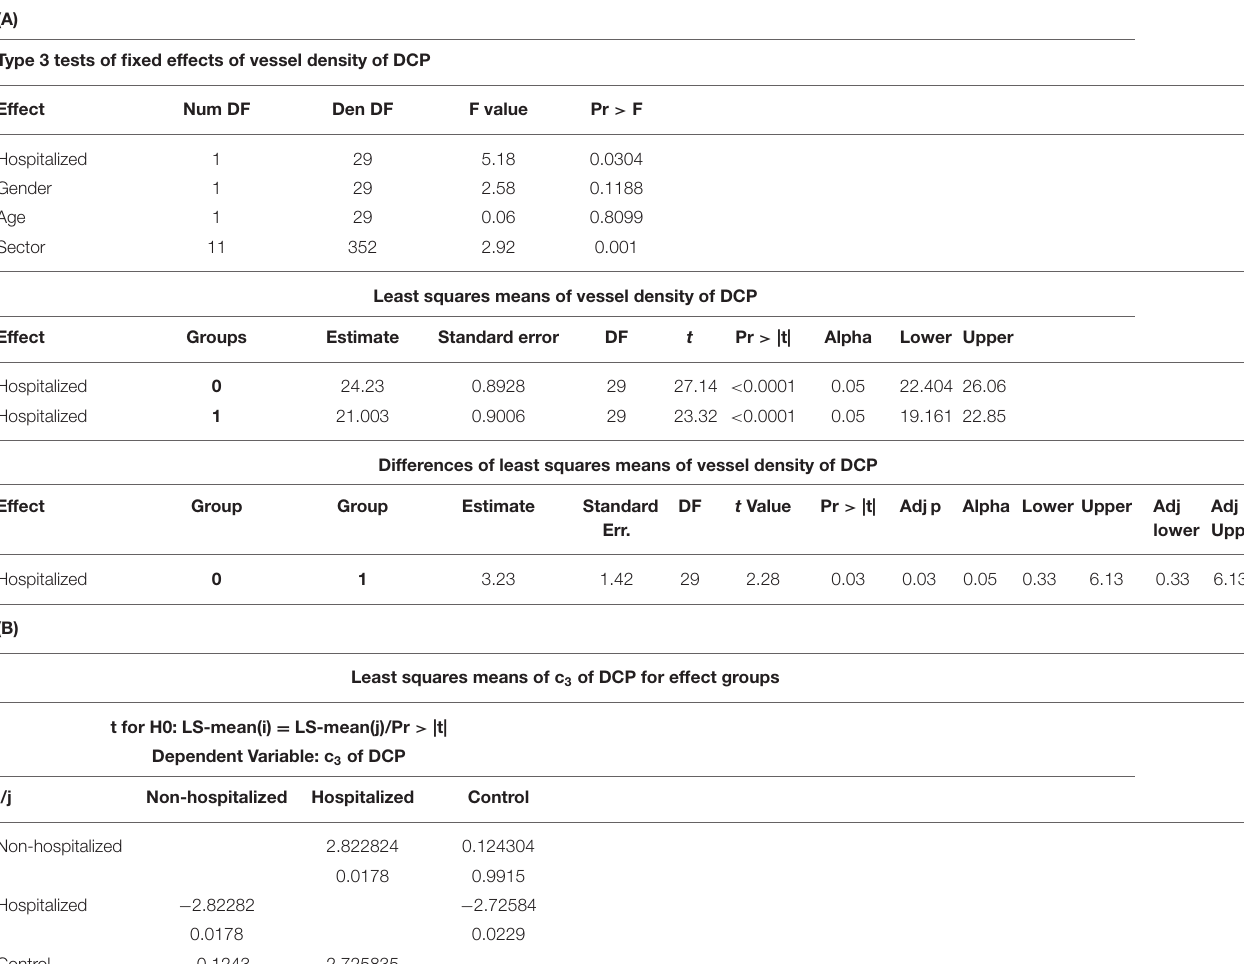
TABLE 2 | Overall (A) and c 3 of (B) vessel density of deep capillary plexus (DCP) of patients post − COVID who were hospitalized and non-hospitalized during COVID-19 infection: (A) mixed model analysis showed a significantly reduced overall LS-mean vessel density (VD) for hospitalized (coded as 1) compared with non-hospitalized